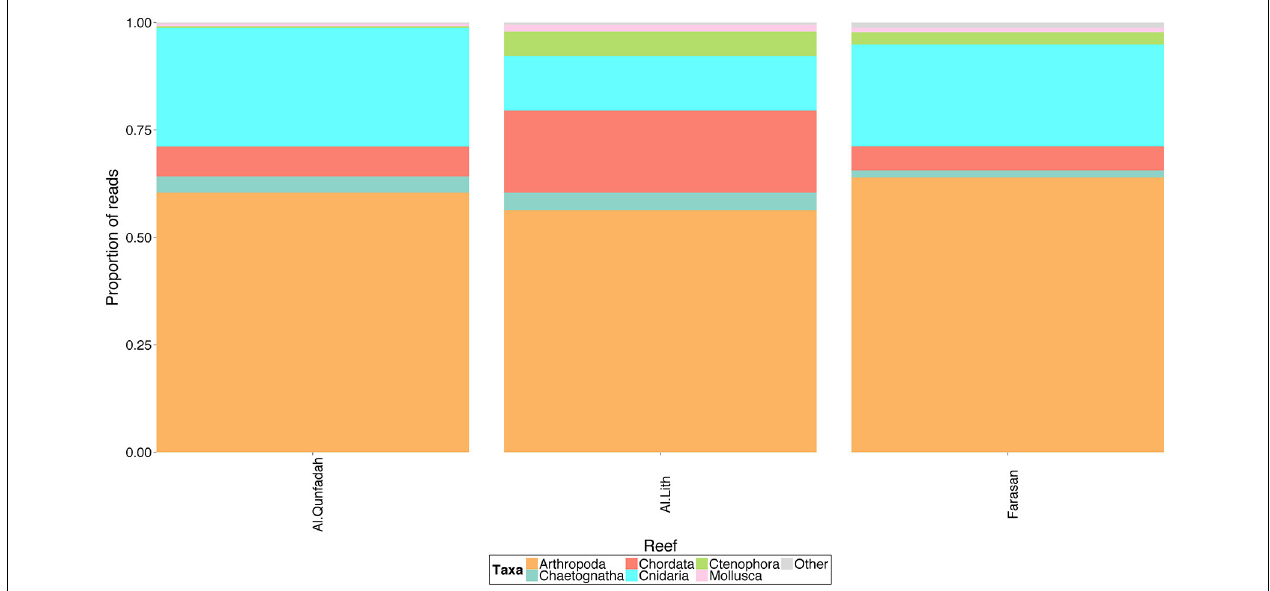
FIGURE 4 | Proportion of reads assigned to metazoan taxa across 3 reef systems in the southern Red Sea.